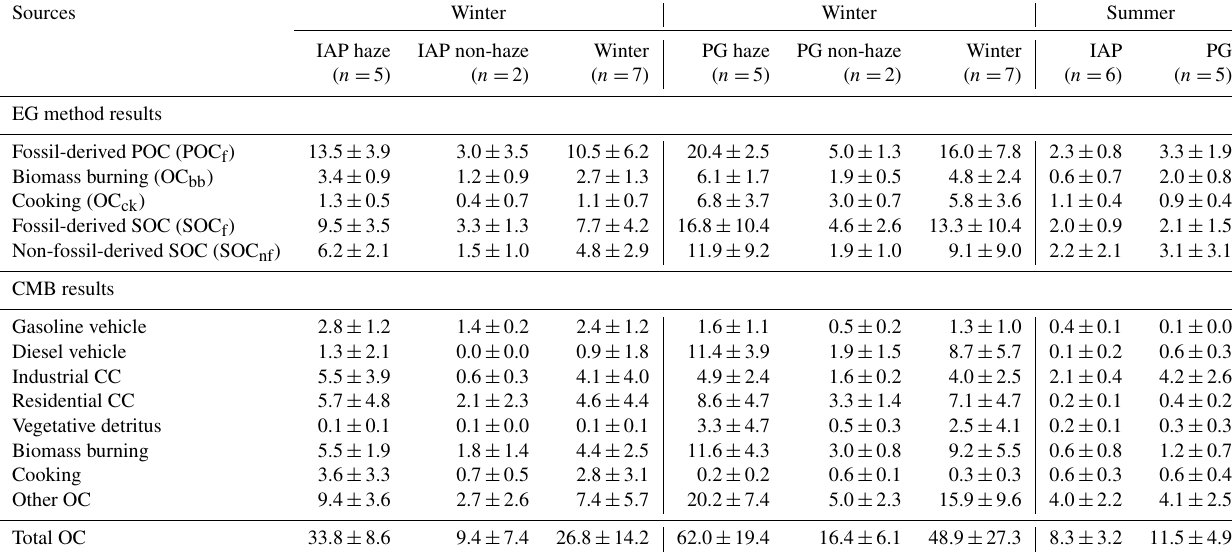
Table 4. Source contribution estimates (µgm − 3 ) for OC at IAP and PG in winter and summer.